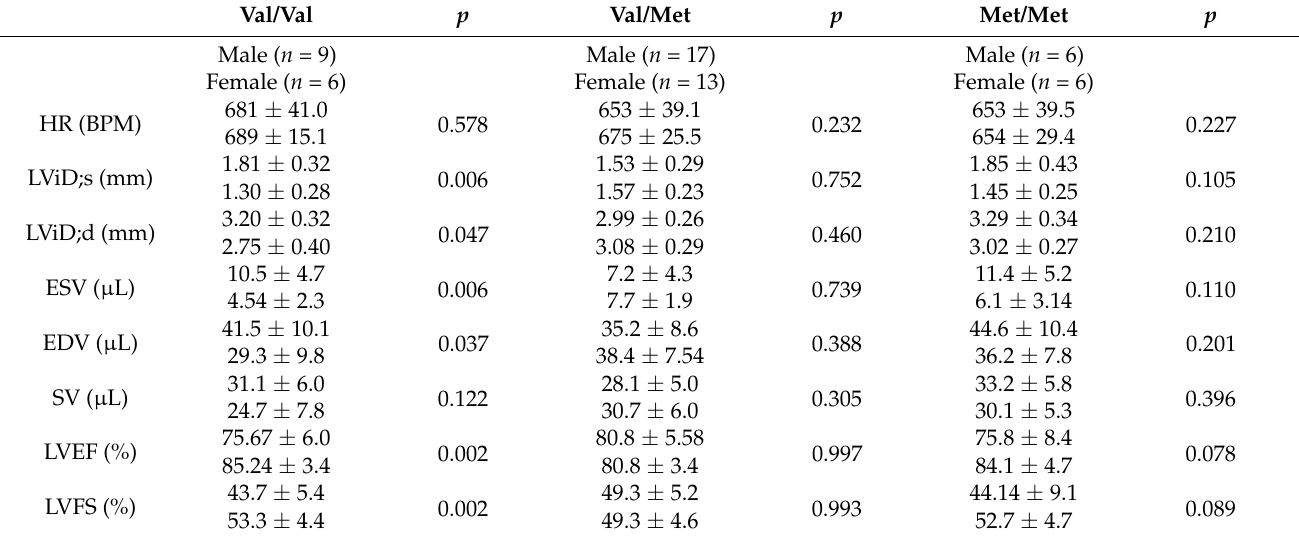
Table 1. Echocardiograph Assessment of Male and Female Mice with and without the rs6265 Allele.